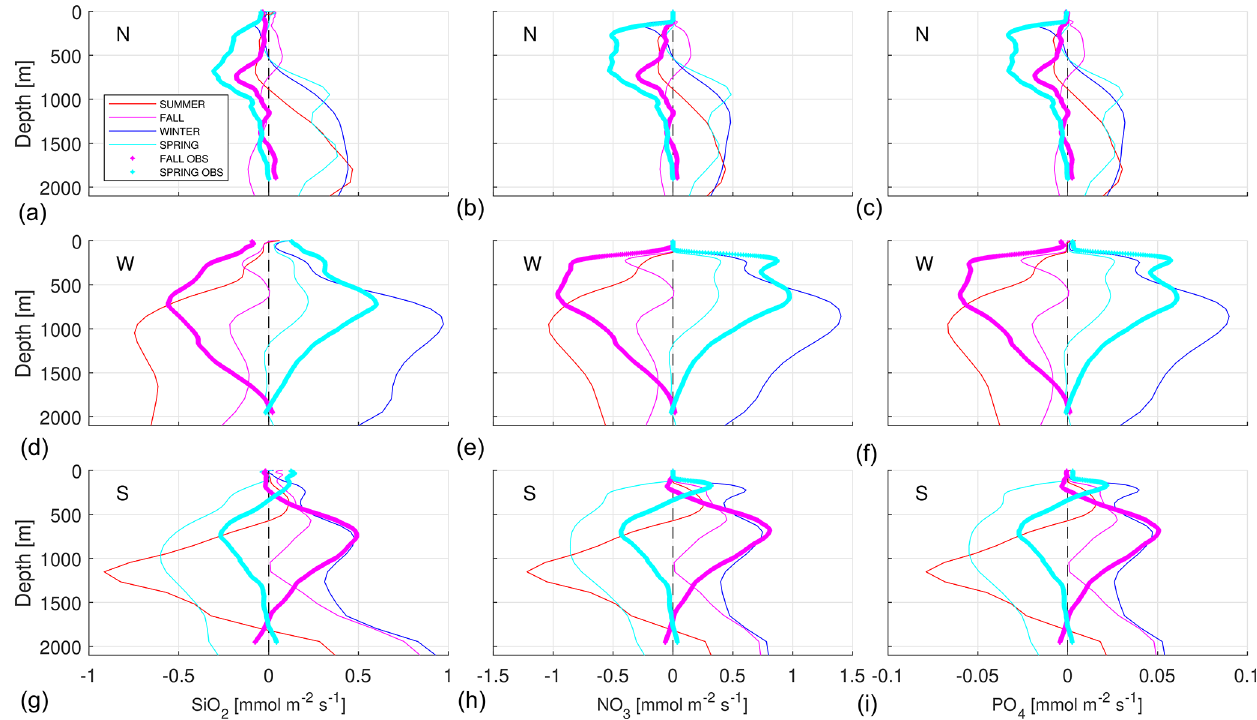
Figure 18. Numerical modeling of seasonal SiO 2 (a, d, g) , NO 3 (b, e, h) and PO 4 (c, f, i) fluxes (mmolm − 2 s − 1 ) at the three key points (N: in the north transect, a, b, c ; W: in the west transect, d, e, f ; S: in the south transect, g, h, i ). The following are represented: summer, from July to September, by the thin red line; fall, from October to December, by the thin magenta line; winter, from January to March, by the thin blue line; and spring, from April to June, by the thin cyan line. The three nutrient fluxes observed in situ in fall (magenta) and spring (cyan) are also plotted with thicker dotted